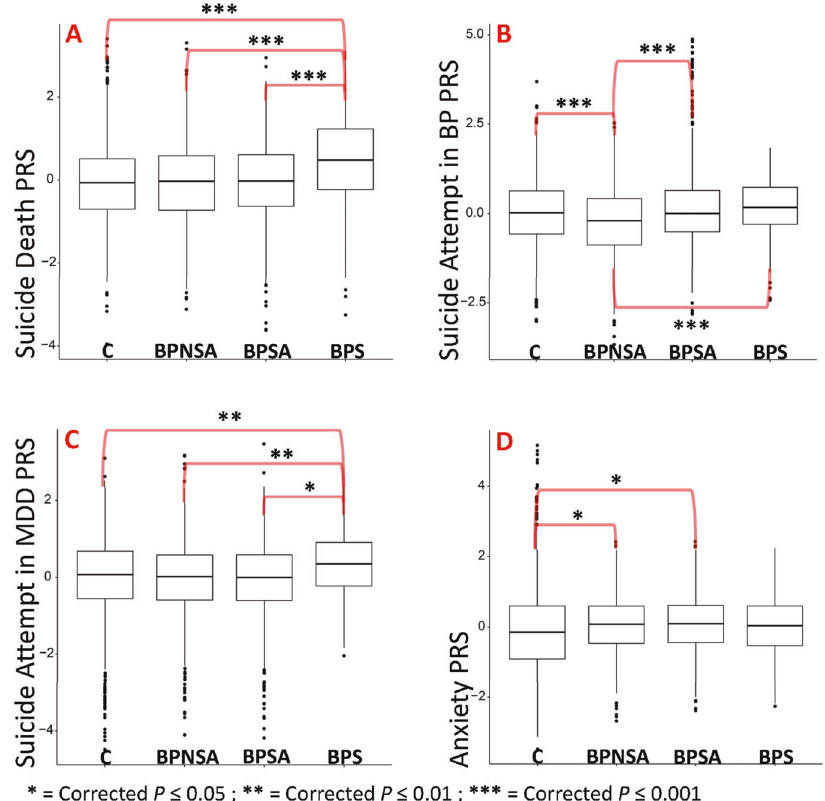
Fig. 3 Suicide death, attempt, and anxiety PRS results. Box plot representations of the top fi ndings from polygenic risk score association testing. Each plot represents comparison group ( x -axis) versus standardized polygenic risk score for the given phenotype ( y -axis). A Suicide death PRS. B Suicide attempt in bipolar disorder PRS. C Suicide attempt in MDD PRS. D Anxiety PRS. Comparison group de fi nitions: BPS = individuals with bipolar disorder who died by suicide, BPSA = individuals with bipolar disorder who have a history of one or more suicide attempts, BPNSA = individuals with bipolar disorder who have no history of a suicide attempt, and C = comparison individuals without several common psychiatric illnesses per self-report [14]. Selected results shown; all displayed results have been corrected for multiple testing (Benjamini – Hochberg method with FDR of 0.05 correcting for 114 tests for all displayed results) and account for critical covariates. All shown results arose from evaluating all subjects (male and